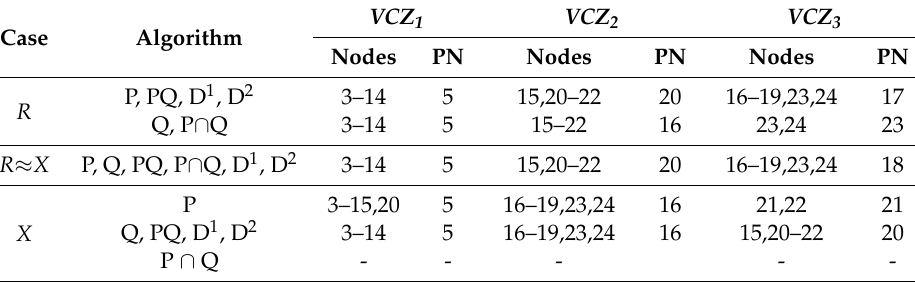
Table 3. Nodes and pilot nodes for three voltage control zones